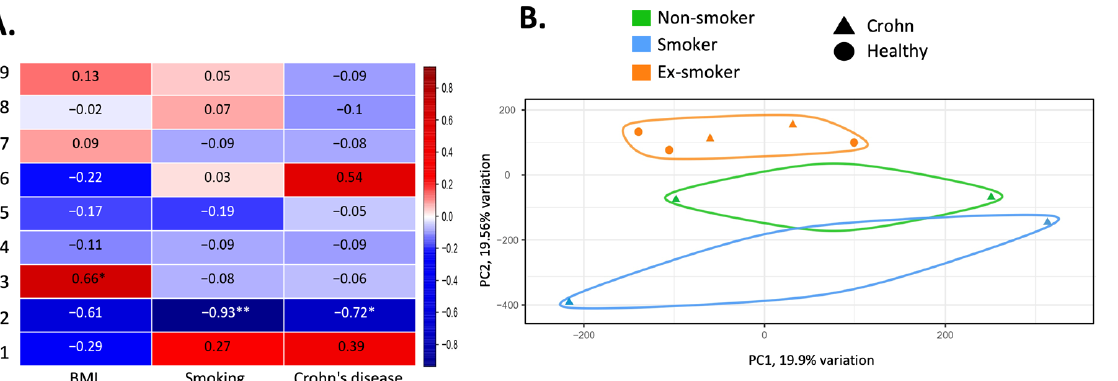
Figure 2. Exploratory data analysis of the di ff erentially methylated positions in adipose-derived stem cells isolated from patients with Crohn’s disease and healthy controls. ( A ) Heat map showing the correlation data between the nine main components and clinical parameters such as body mass index (BMI), Crohn’s disease or smoking habit. Each cell of the heatmap shows the Pearson correlation coe ffi cient. Asterisks indicate signi fi cant correlation (* p < 0.05; ** p < 0.01). ( B ) Principal component (PC) analysis demonstrating the fi rst two principal components of the overall DNA methylation pro fi les, showing a discernible di ff erentiation between patients with Crohn’s disease who are smokers (blue triangles), non-smokers (green triangles) or ex-smokers (orange triangles). Also, healthy controls are represented with a circle. ( C ) Gene ontology enrichment analysis of the biological processes using the whole set of genes with signi fi cant di ff erentially methylated positions (DMPs). Di ff erent color scale represents the p -adjusted values and the size of the circles represents the number of genes implicated in each process. ( D ) Functional analysis of gene-associated DMPs in Crohn’s disease. Left. Gene–gene interaction involving 26 genes implicated in wound healing and